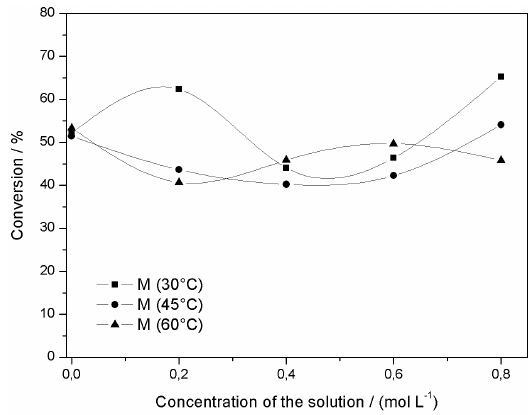
Figure 6. Comparative conversion of oleic acid obtained from reactions in 30 °C, 45 °C and 60 °C using natural montmorillonite clay and treated montmorillonite clay with sulfuric acid at different concentrations (0.2 – 0.8 mol L –1